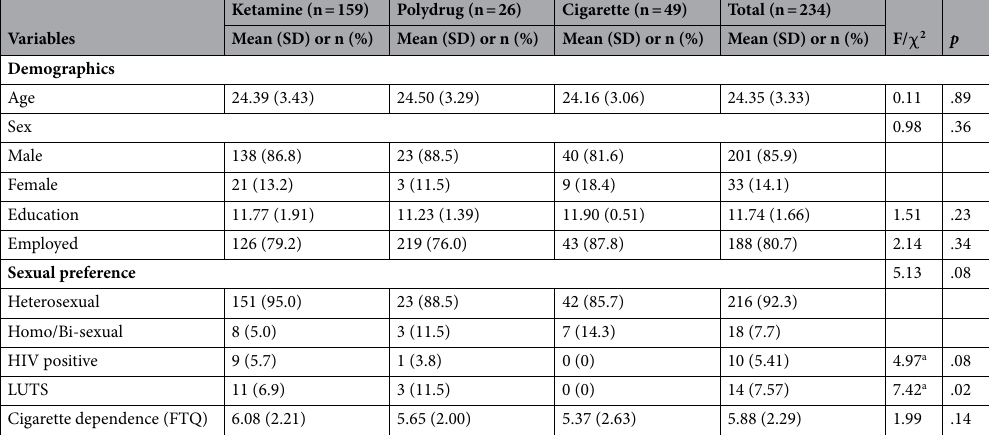
Table 1. Background information of patients with Ketamine use, polydrug use and cigarette smoking. There was none in the cigarette group with HIV or LUTS. LUTS Lower urinary tract symptoms. a Fisher’s exact